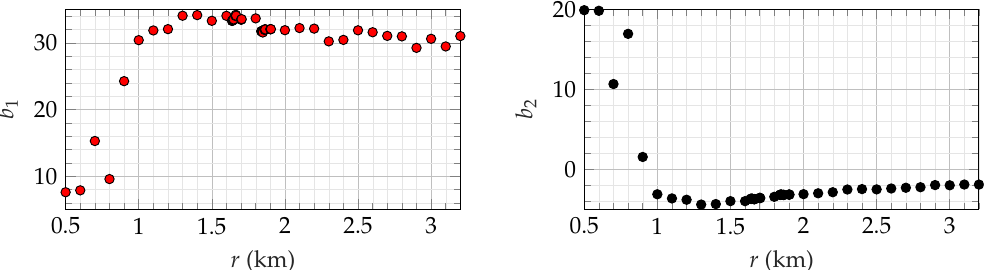
Figure 16. Coefficients of the Bowen coherence model fitted to the wind coherence measured from 18 May 2016 to 21 June 2016 using LE only (E-W configuration), with 10 m 0.5km r ≤ ≤